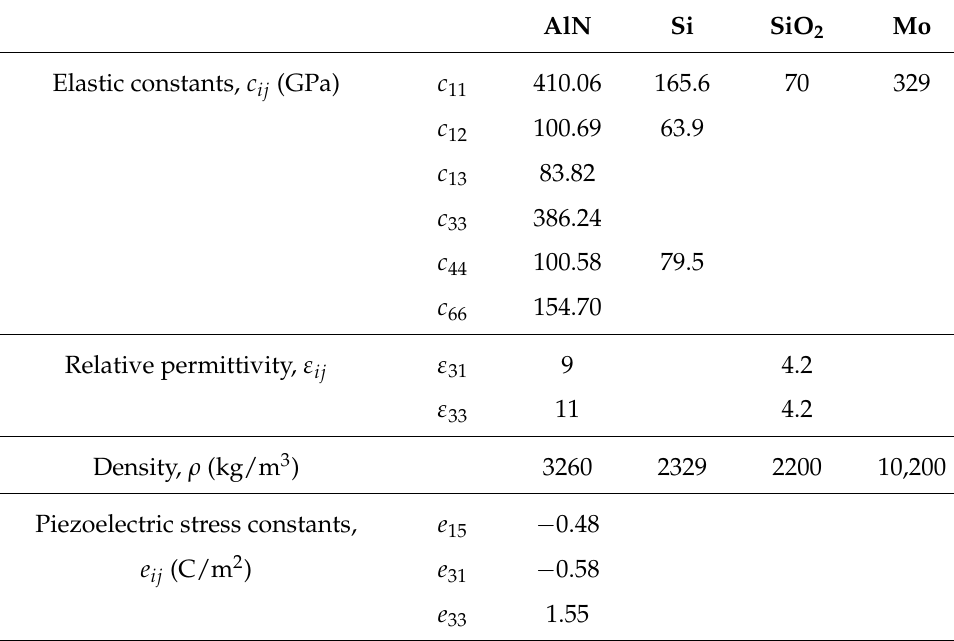
Table 2. Material parameters of all layers used in the